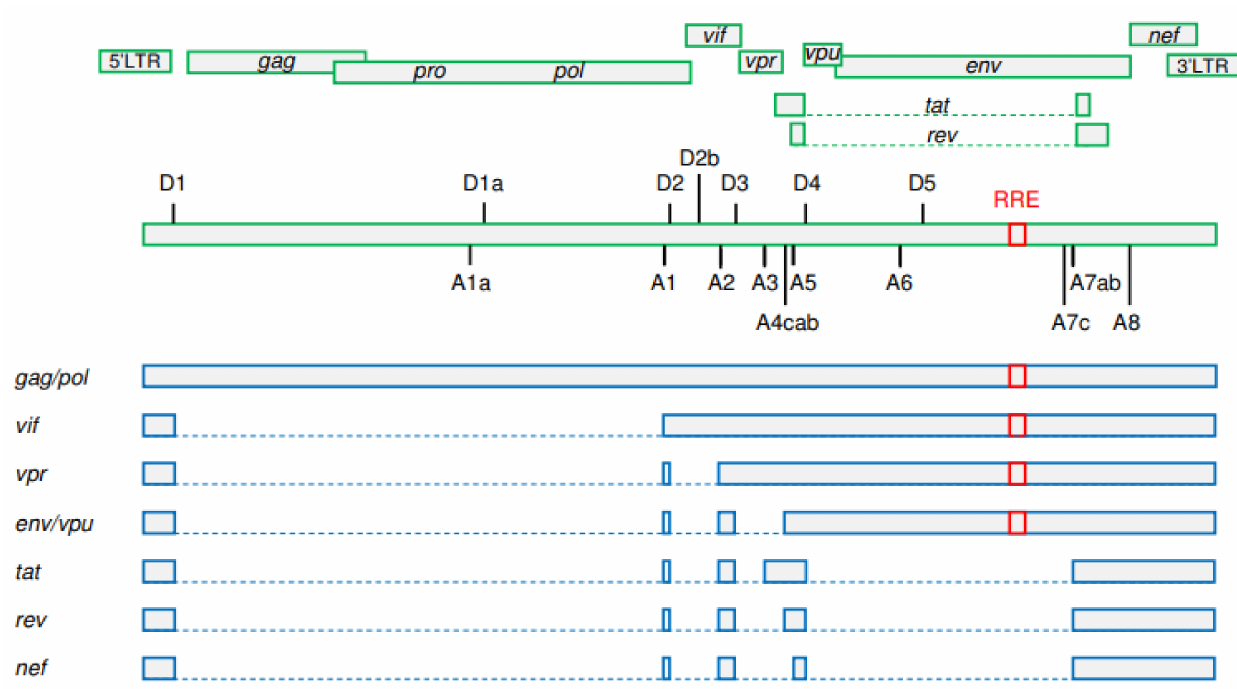
Figure 1. A simplified schematic representation of HIV-1 splicing. Upper panels: HIV-1 open reading frames. Positions of donor (D1–D5) and acceptor (A1–A8) splice sites and of the Rev response element (RRE) are shown. Lower panels: the main representatives of unspliced, incompletely spliced, and multiply spliced HIV-1 RNA classes. Gag and Pol proteins are expressed from the 9 kb unspliced RNA. The other HIV-1 proteins are expressed from either incompletely (Vif, Vpr, Env, and Vpu) or multiply (Tat, Rev, and Nef) spliced RNAs. RRE is present in unspliced and incompletely spliced RNAs but not in multiply spliced RNAs. Exons are shown by bars and introns by dashed lines. (Figure adapted from [24]; reproduced, with permission, from